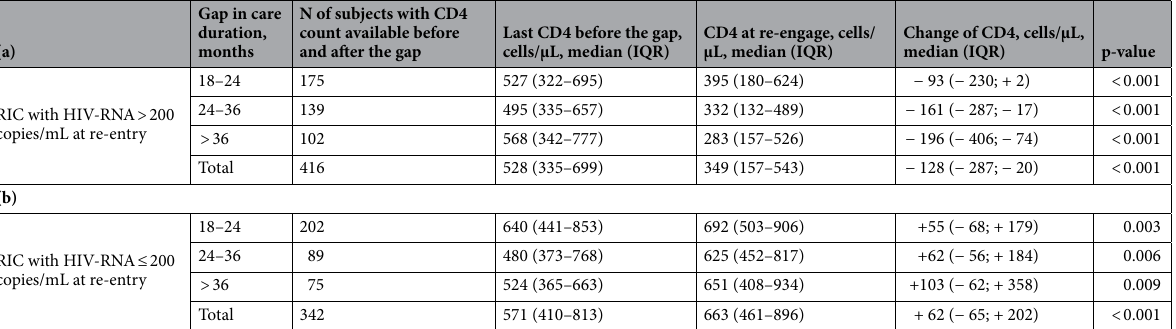
Table 5. Median value and interquartile range (IQR) of CD4 cell count before and after the gap in care according to gap duration and to HIV-RNA level at re-entry (a) HIV-RNA > 200 copies/mL and (b) HIV- RNA ≤ 200 copies/mL.